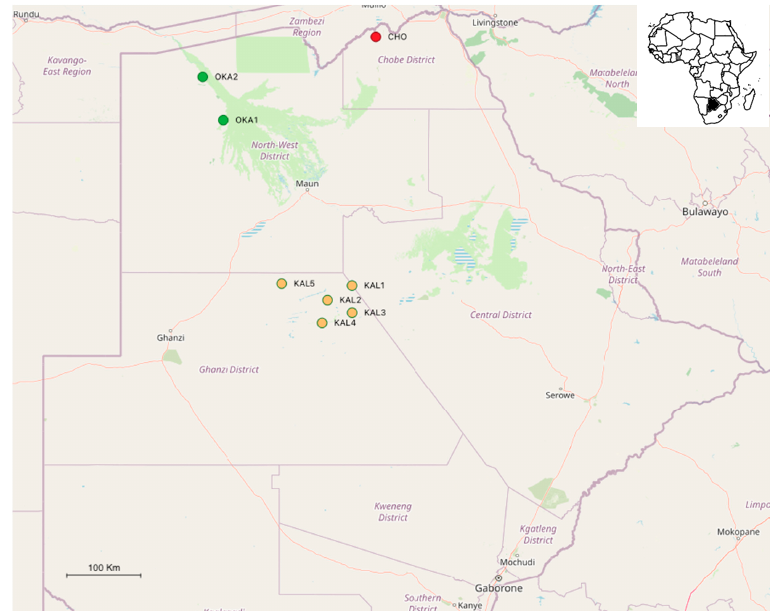
Figure 1. Map of Botswana with sampling stations: North-East Central Kalahari Game Reserve (CKGR)—KAL1 to KAL5; Okavango Delta—OKA1 and OKA2; and the Chobe enclave—CHO. See Table 2 for details of stations. Thumbnail picture shows the location of Botswana in